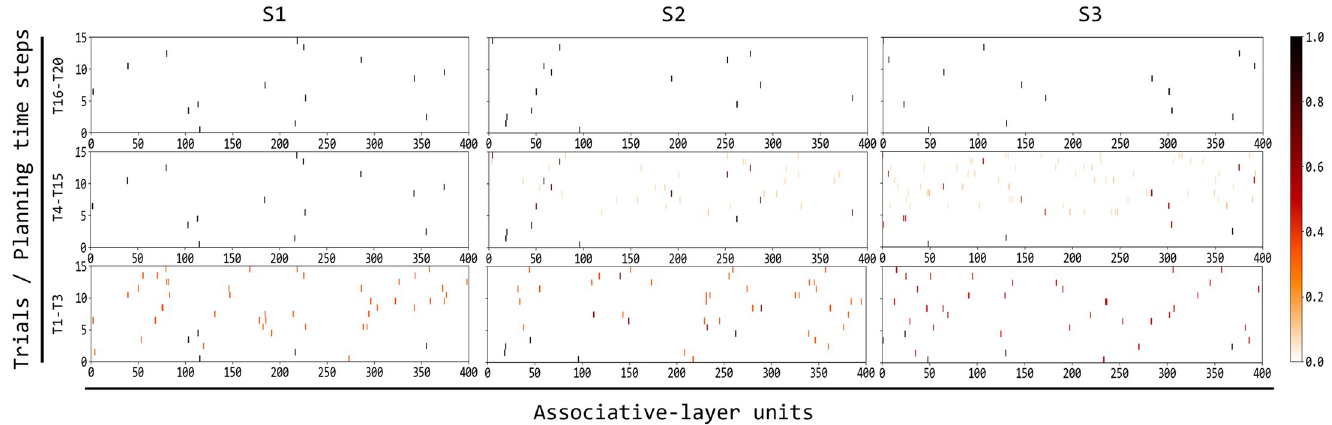
Fig 6. Evolution of the spiking activity of the associative layer units while planning, across the experiment trials. To best interpret the figure, recall that: 15 planning cycles formed one planning sequence (forward sampling), a variable number of planning sequences was generated in one trial for a given colour, 3 trials for the different colours formed a triplet, 20 triplets formed the whole test. The figure shows data collected while the model planned during the trials of the experiment related to each colour, from trial one (T1) to trial 20 (T20). Each column of graphs corresponds to a different colour stimulus, respectively S1, S2, and S3. For each of the nine graphs, the x-axis indicates the indexes of the 400 neurons of the associative layer, and the y-axis indicates the 15 planning cycles of the planning sequences produced in each trial (in each graph the planning cycles progress from bottom to top). Each graph in particular reports the spikes of each neuron for multiple trials (T1-T3 for the bottom row of graphs, T4-T15 for the middle row, and T16-T20 for the third row) and for the multiple planning cycles of those trials: the colour of each little line indicates the proportion of spikes of the corresponding neuron during those trials and cycles.